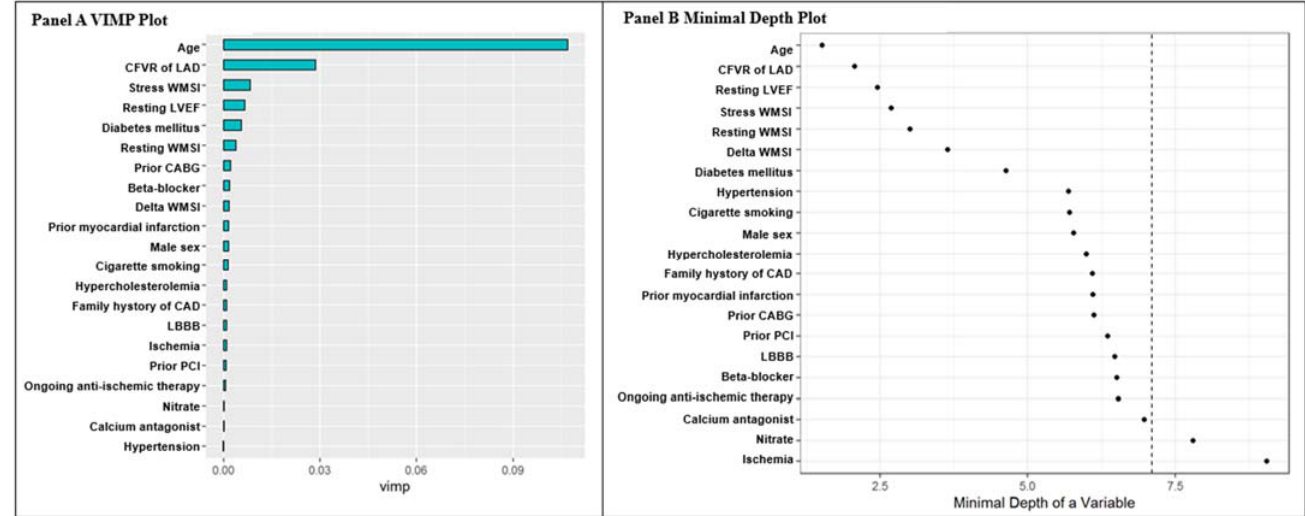
Figure 2. Panel A: Random forest VIMP plot. Bars are colored by a sign of VIMP; longer blue bars indicate more important variables. Panel B: minimal depth variables in rank order, most important at the top. The vertical dashed line indicates the maximal minimal depth for important variables. The mean of the minimal depth distribution is used as the threshold value for deciding whether a variable’s minimal depth value is small enough for the variable to be classified as strong.